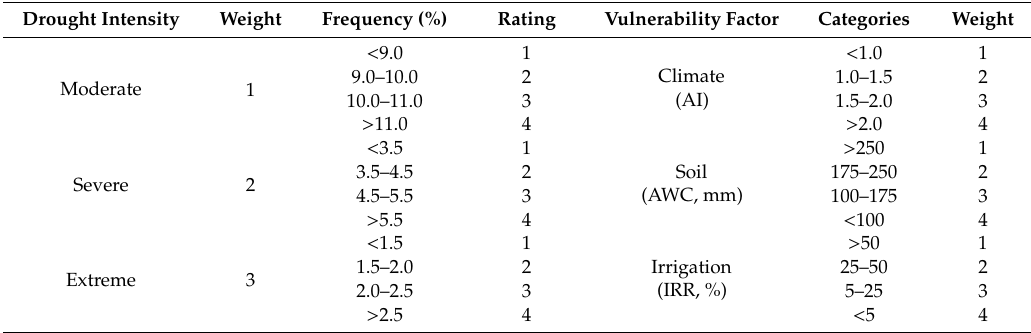
Table 2. Weight and rating scores based on the cumulative probability distribution of SPEI [24,41] and the used factors and their weights used for drought vulnerability assessment [42]. AI: aridity index, AWC: available soil water-holding capacity, IRR: the percentage of total area equipped for irrigation. Drought